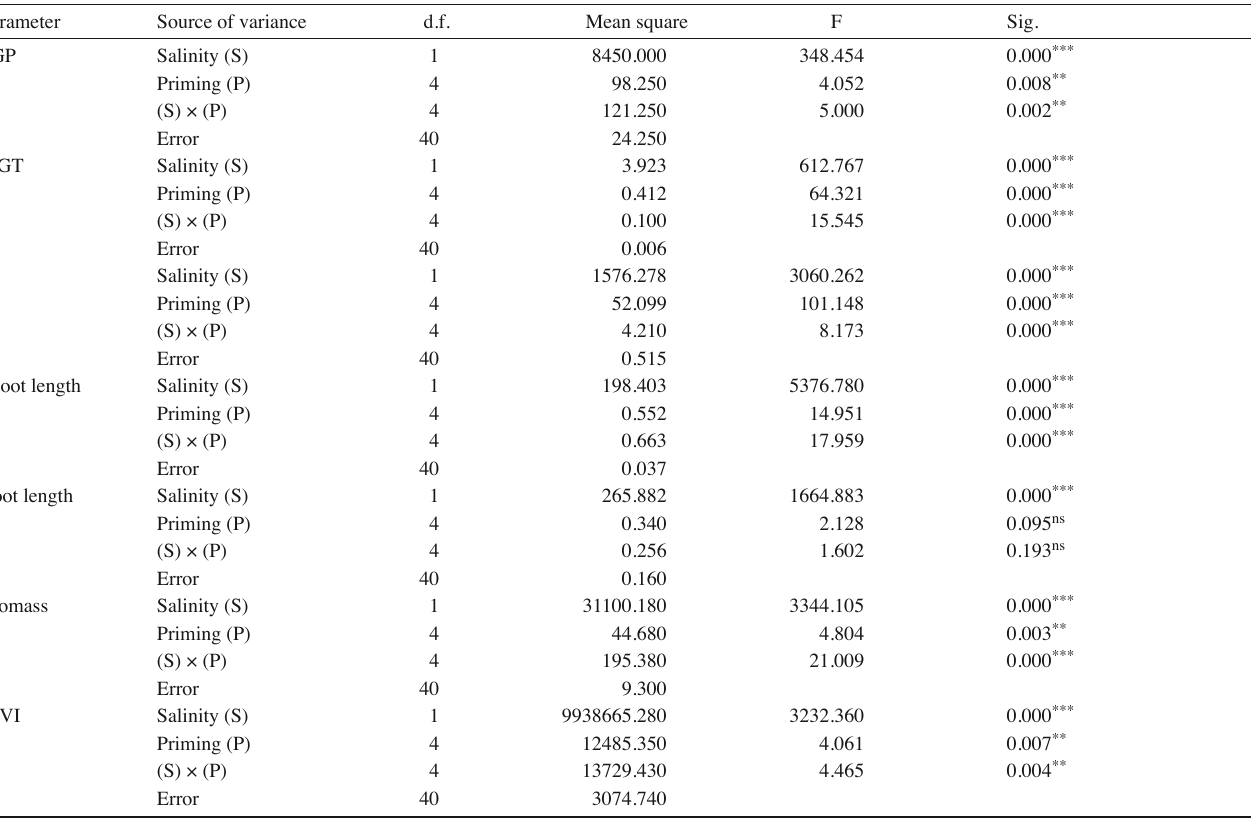
Tab. 1: Two-way ANOVA analysis of priming, salinity, and their interactions for seed germination (FGP: final germination percentage, MGT: mean germination time, GI: germination index) and morphological parameters of rice seedlings (Shoot length, Root length, biomass and vigour index) Parameter Source of variance